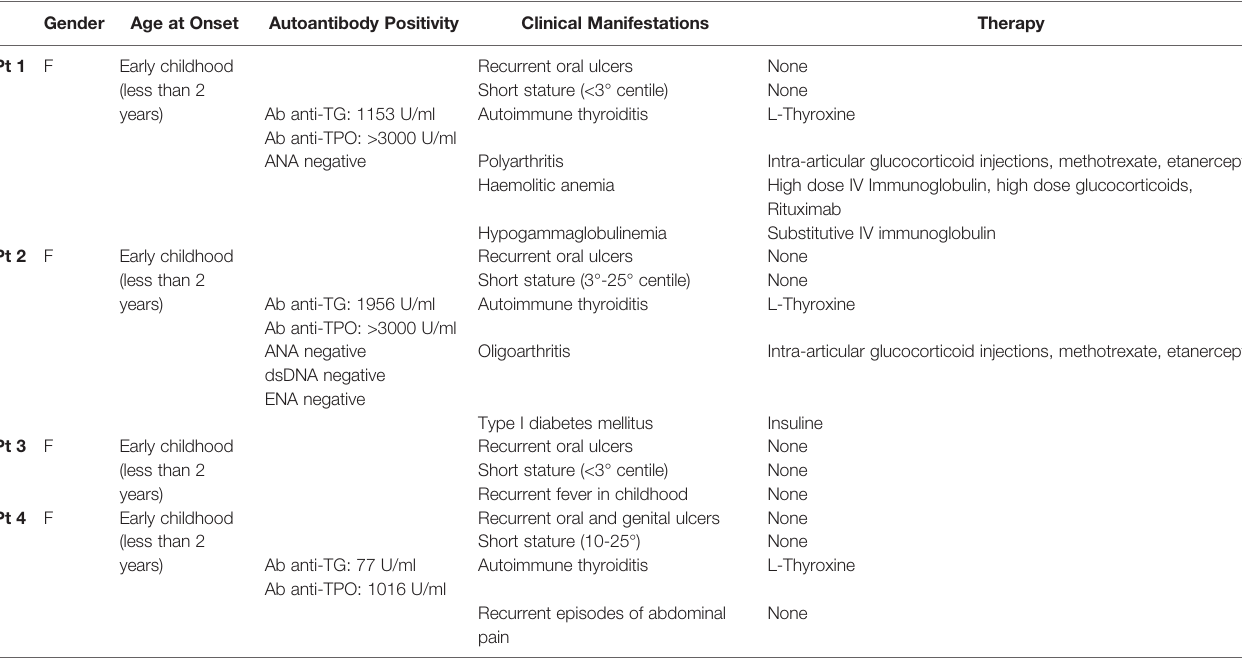
TABLE 1 | Clinical and laboratory characteristics and treatment of the patients.